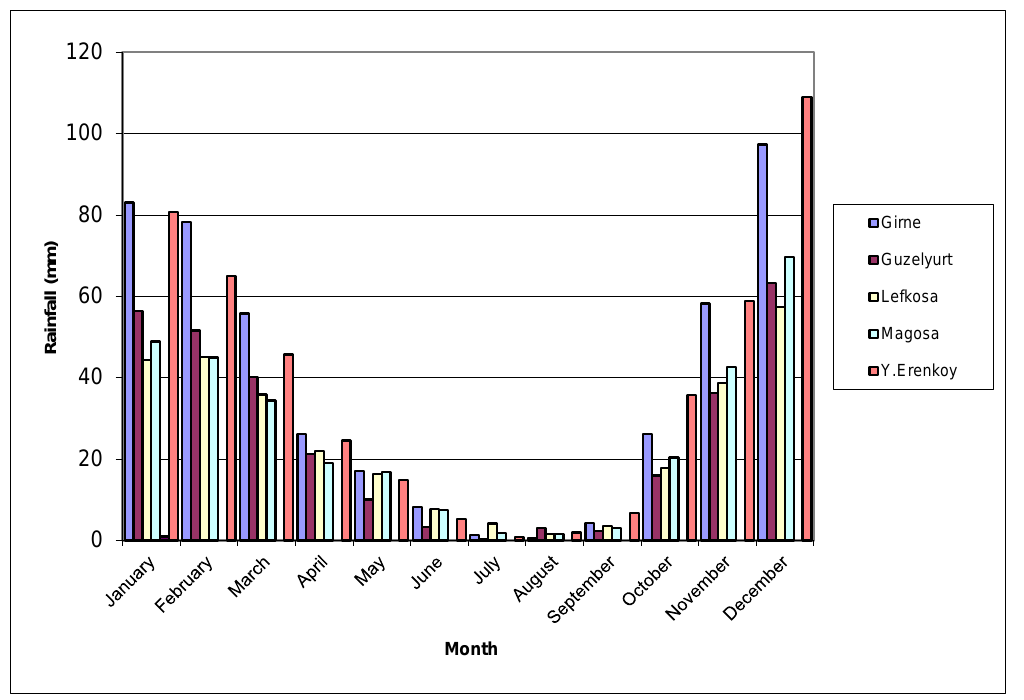
Figure 3. Monthly average rainfall values based on different regions of NC between 1975 and 2001.